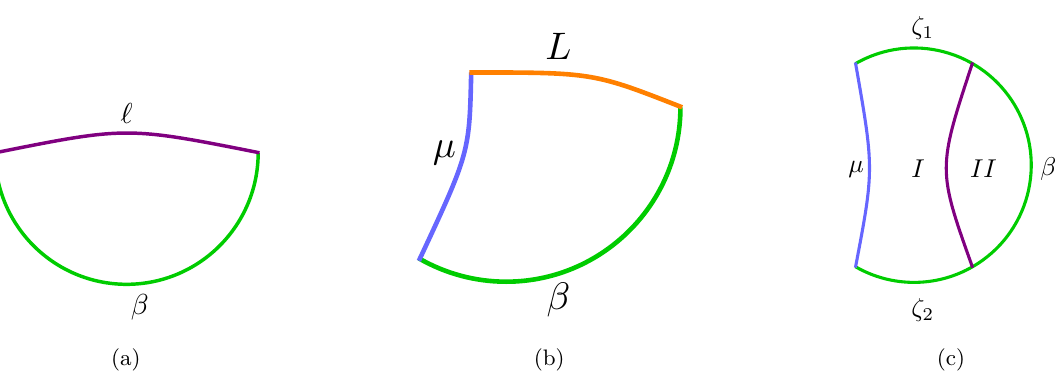
Figure 1 . Three possible disk configurations corresponding to different wavefunctions. Figure (a) is the wavefunction of the Hartle-Hawking state of the two-sided AdS system in JT gravity. Figure (b) and figure (c) are two options in the presence of an EOW brane. While in figure (b) we see a geodesic connecting the EOW brane to the asymptotic boundary, for figure (c) the geodesic connects to two different points on the asymptotic boundary. An orange curve corresponds to the former geodesic and a violet curve to the latter. Green denotes an AdS boundary and blue an EOW brane,